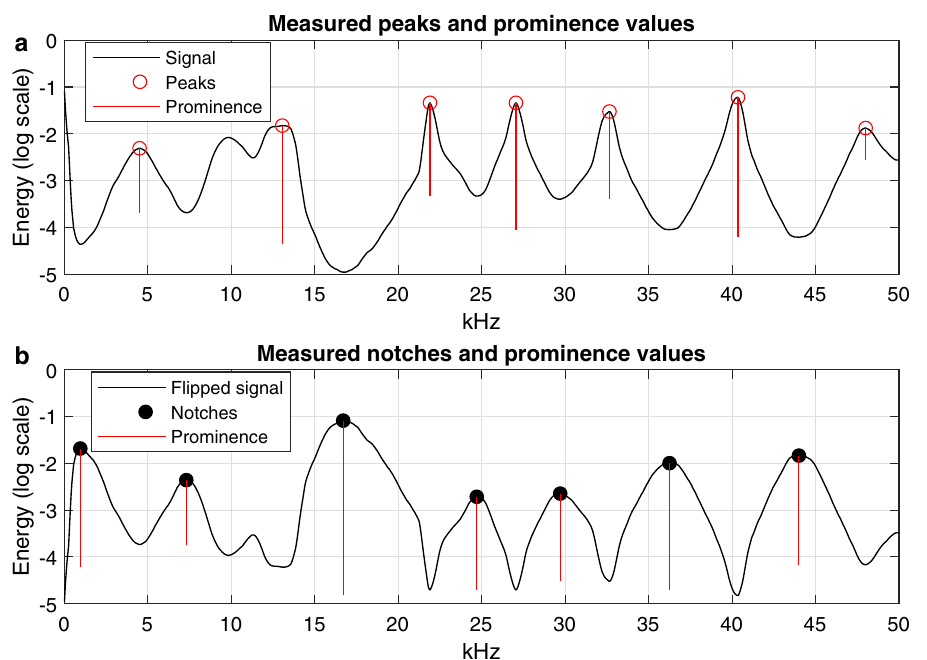
Figure 5. Example of locating peak and notch frequencies and how prominent they are compared to other peaks and notches. The wave form in ( a ) is the smoothed energy summation sequence from the Hilbert spectrum of the Lo signal in Fig. 1. Subplot ( b ) is a flipped version of the energy summation sequence for the convenience of extracting notch frequencies and their prominence values. The length of the red line represents the prominence value of a peak or